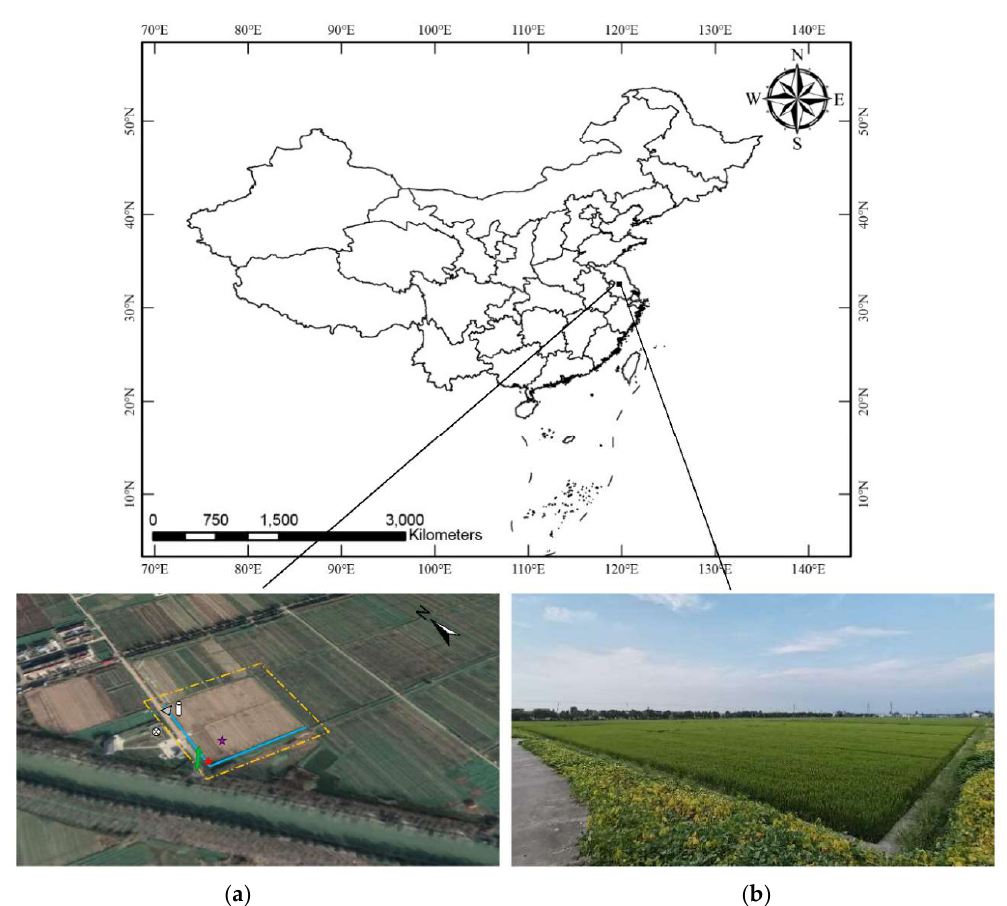
Figure 1. Schematic diagram of the study area: ( a ) three-dimensional view derived from satellite image; ( b ) on-site view. The distance between the two sampling points at the field ditch is around 93 m. boundary of the stud y area, position and angle of view of Figure 1b, field ditch, weather station. sampling point at the midpoint of the field ditch, v-notch weir (sampling point at the outlet of the field ditch), sampling point of the paddy surface water , 90-cm depth well (sampling point of the paddy groundwater) .